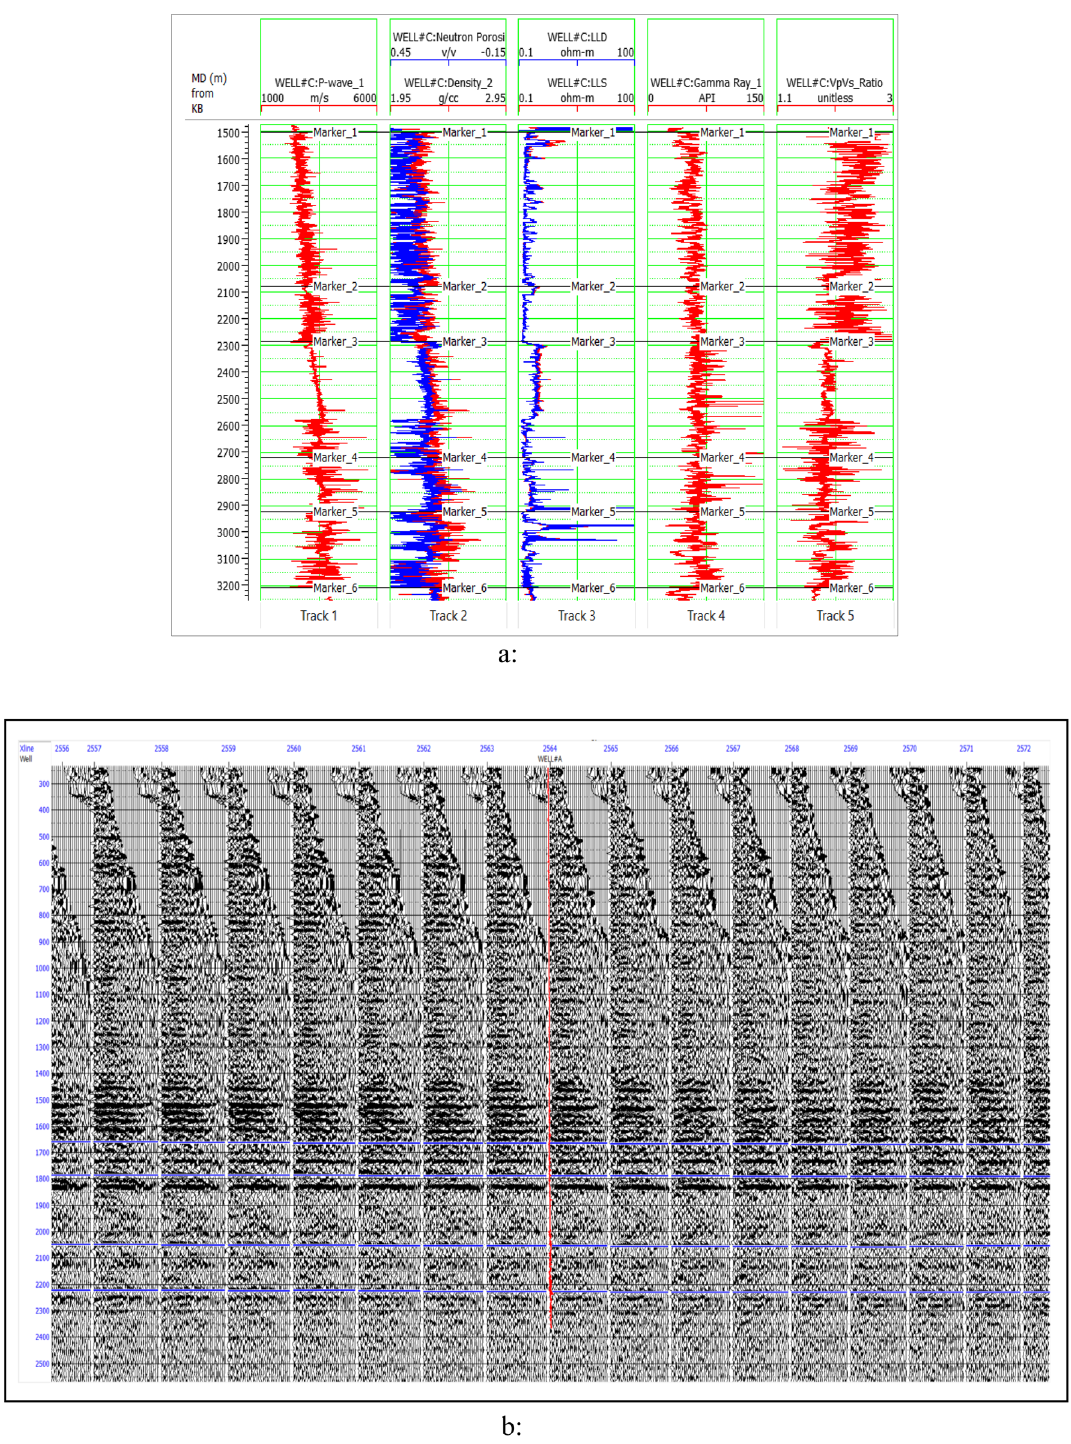
Figure 2. ( a ) Well logging curves of Well#03 in the study area. ( b ) Seismic Raw data (offset gathers) used in this